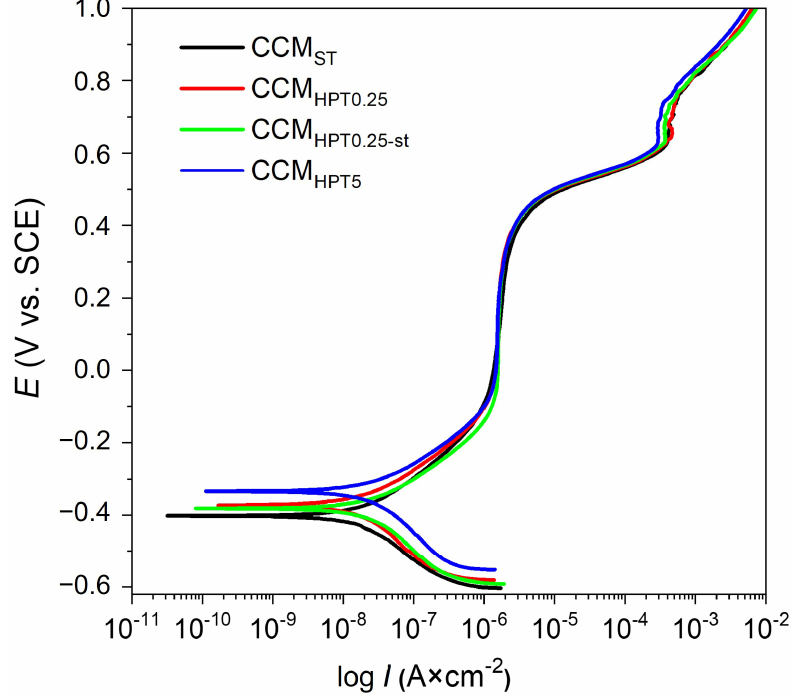
Figure 4. Potentiodynamic scanning (PDS) curves of the CCM samples in PBS at body temperature. Table 2. Open-circuit potential ( E ocp ), corrosion potential ( E corr ), passivation current density ( i pass ), and breakdown potential ( E bd ) values obtained from PDS curves of the CCM samples.